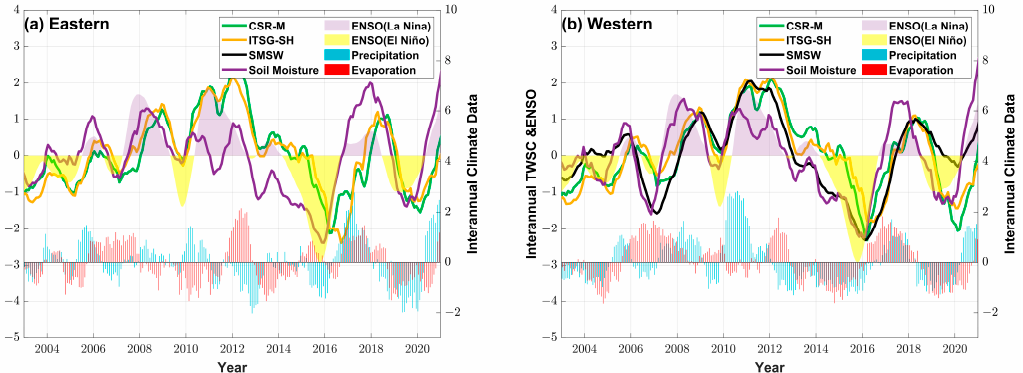
Figure 8. The interannual signals (CSR-M, ITSG-SH, SMSW, soil moisture, precipitation, and evapo- ration) and the ENSO index in eastern ( a ) and western ( b )